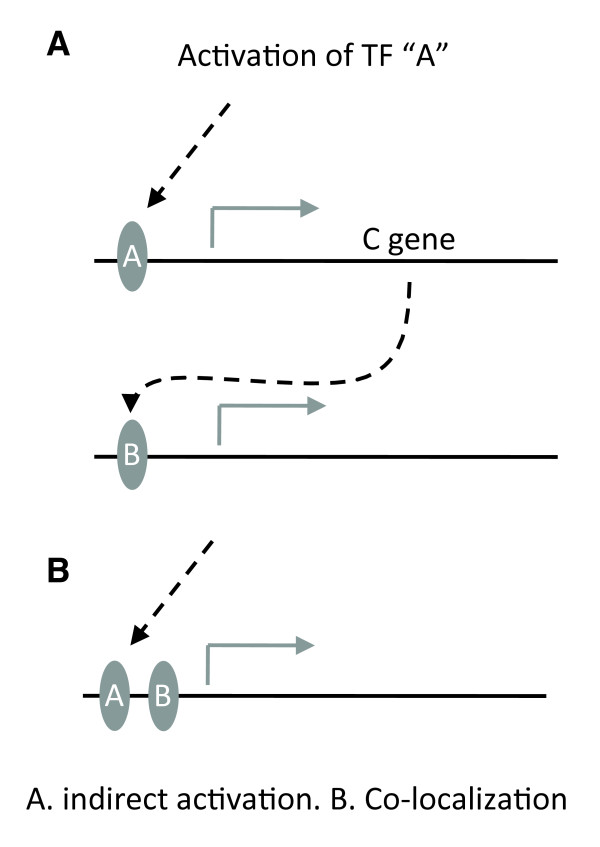
Possible models for the selection of an indirect target. For both panels, site A is the direct target of a transcription factor (TF) "A" and B is the indirect site. The figure illustrates two models for the detection of site B, in addition to site A. Panel A. Sequential model. One of the gene products activated by site A ('C gene' in the figure) targets site B. Panel B. Bystander model. Sites A and B coexist in the same promoter and may cooperatively function to activate the target promoter. Another possibility is that site B is not involved in the gene activation by TF "A" but is involved in a distinct signaling pathway, resulting in site A and B, having only a biological relationship. A possible example of this latter case is the coexistence of a site for an environmental response and for tissue-specific expression (e.g., light response and leaf-specific expression).